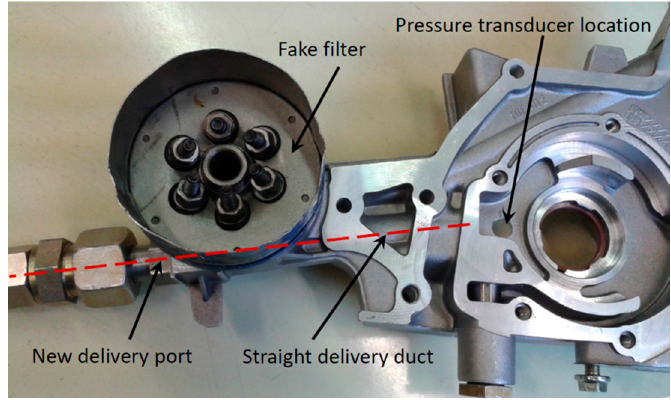
Figure 15. Hydraulic scheme of the test rig.